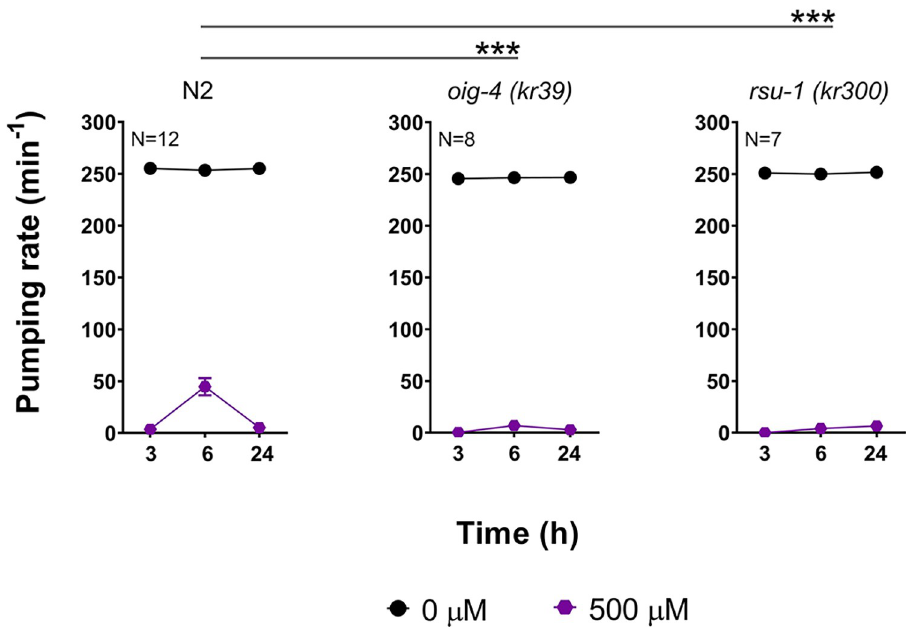
Fig 10. Mutants that underpin the synaptic organization of the L-type receptors modifies the pharyngeal pumping observed in nematodes exposed to paraoxon-ethyl. The pharyngeal function of wild type nematodes exposed to paraoxon-ethyl exhibited drug-induced plasticity. Data are shown as mean ± SEM of 12 worms in at least 6 independent experiments (N = 12). OIG-4 is a muscle-secreted protein involved in the location of the L-type receptor at the body wall NMJ [55]. Oig-4 lacking nematodes are deficient in the in-drug recovery of pharyngeal pumping observed in the wild type worms. Data are shown as mean ± SEM of 8 worms in at least 4 independent experiments (N = 8). RSU-1 is a cytosolic muscle protein involved in maintaining the equilibrium between synaptic and extra- synaptic nicotinic receptors [54]. rsu-1 lacking nematodes exposed to paraoxon-ethyl are deficient in the within drug recovery of the pharyngeal pumping. Data are shown as mean ± SEM of 7 worms in at least 4 independent experiments (N = 7). Statistical significance was calculated by two-way ANOVA test followed by Bonferroni corrections. *** p �